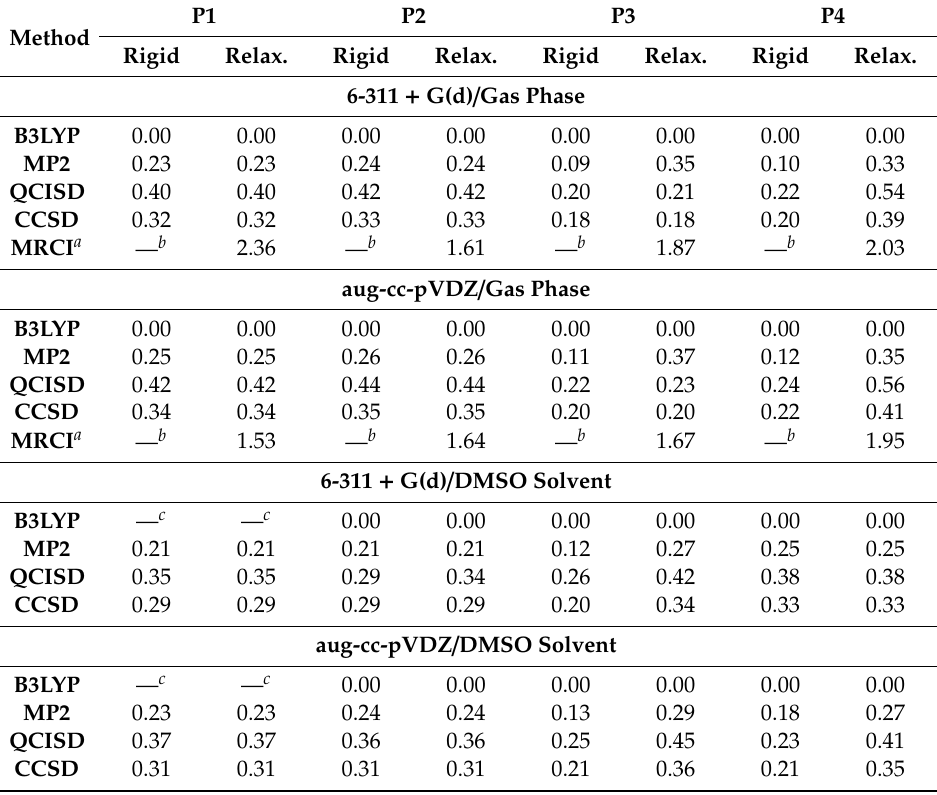
Table 3. Percentage values of y 0 for the investigated heterocycles in gas phase and DMSO solvent. P1 P2 P3 P4 Method Rigid Relax. Rigid Relax. Rigid Relax. Rigid